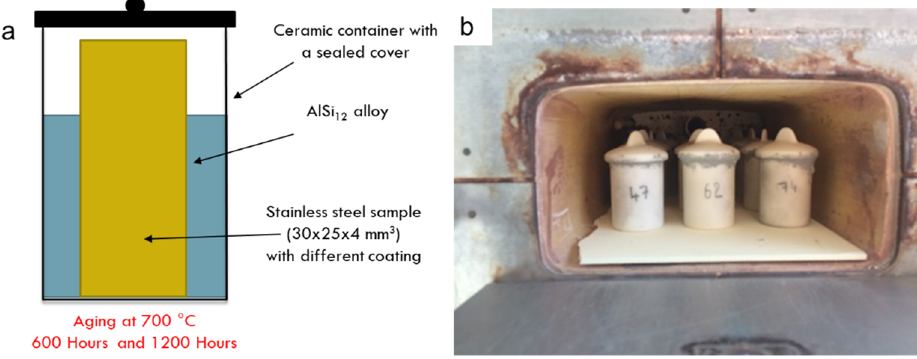
Figure 1. Corrosion resistance of a 304L stainless steel coated with a protective layer in molten AlSi 12 during 600 and 1200 h at 700 °C ( a ) schematic view and ( b ) ceramic containers in the furnace.